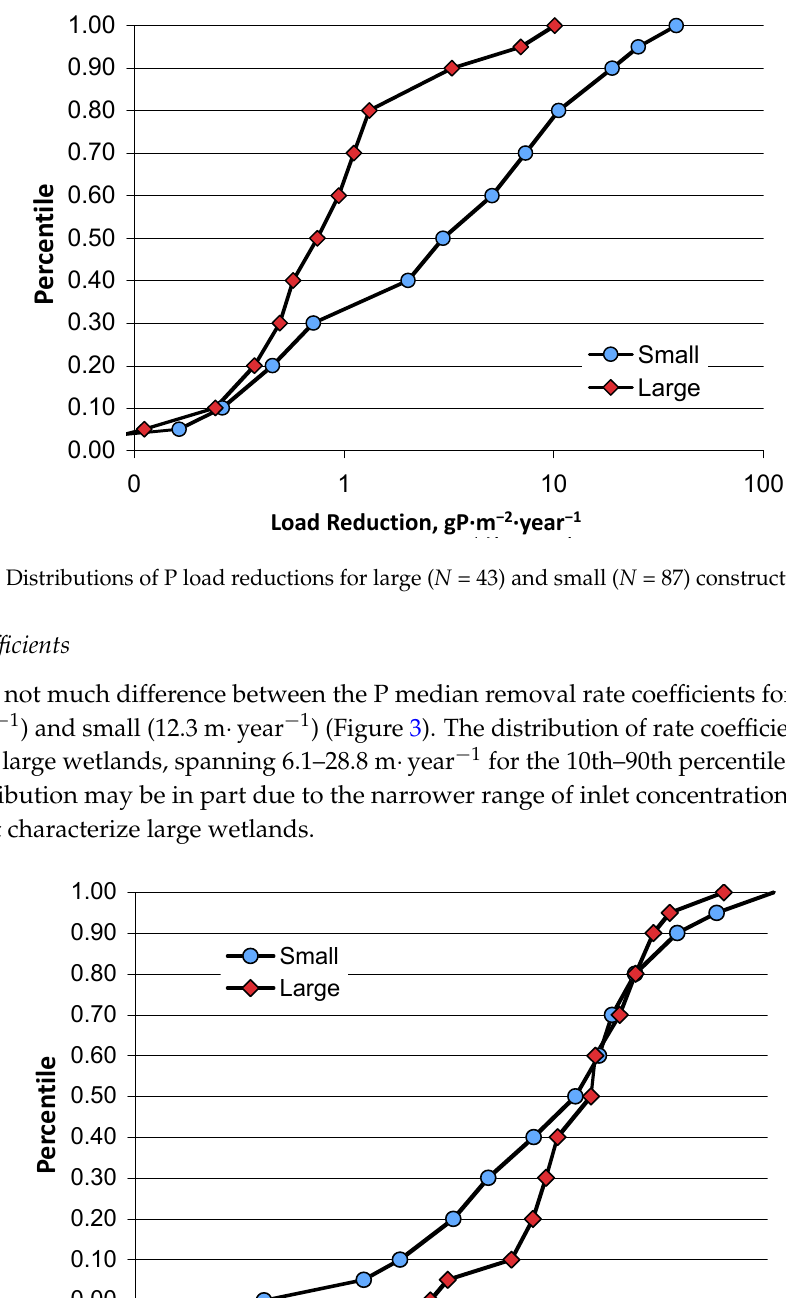
7 of 35 Figure 1. Distributions of P concentration reductions for large ( N = 43) and small ( N = 87) constructed wetlands.